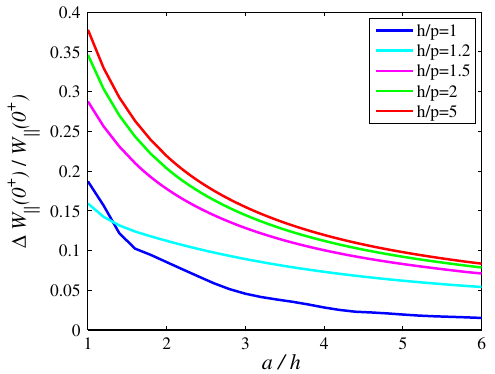
FIG. 5. Wave numbers (up) and loss factors (down) of the first two bands of modes as functions of horizontal wave number l , for nominal LCLS dechirper parameters with a ¼ 0 . 7 mm.